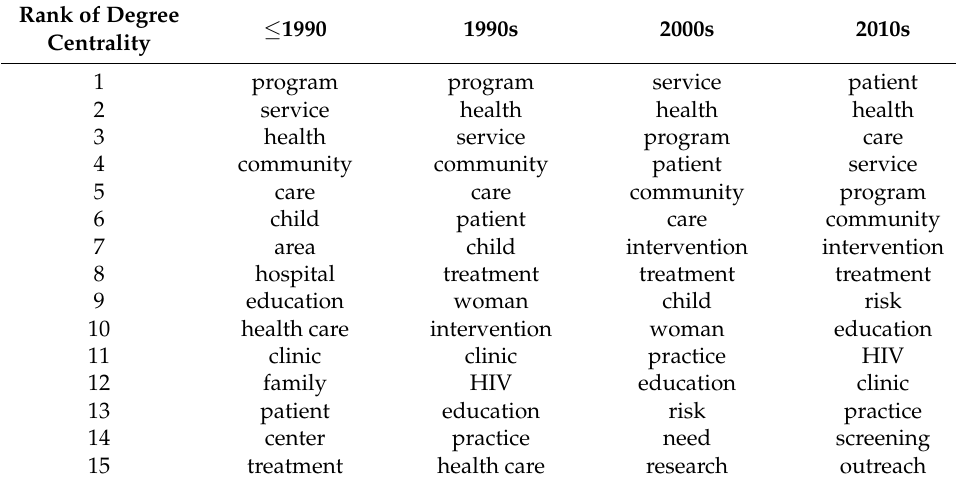
Table 2. Top 30 Keywords of Degree Centrality over